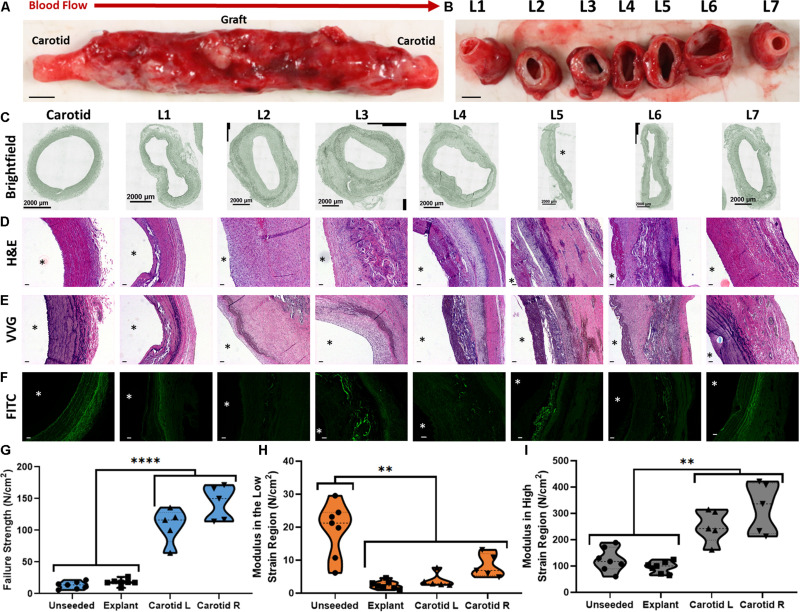
Large animal implantation and explant analysis of a large seeded construct. (A,B) Macroscopic image of the explanted TEVG (A, intact and B, longitudinally sectioned) after 10 weeks as a carotid interposition graft in a sheep model. Scale bars depict 5 mm. (C) Brightfield images of sections L1 to L7. (D) H&E staining of sections L1 to L7 demonstrating cellular distribution in the graft and neo-intima formation. (E) VVG staining of sections L1 to L7 demonstrating elastin distribution in the graft neo-tissue. (F) Auto-fluorescence of the PEUU material remaining in the graft. Scale bars depict 100 μm. (G) Failure strength, (H) modulus in the low strain region and (I) modulus in the high strain region for the unseeded scaffold, the explanted TEVG and the native carotid arterial tissue. ∗∗ indicates statistical significance at p < 0.01 and **** indicates statistical significance at p < 0.0001.